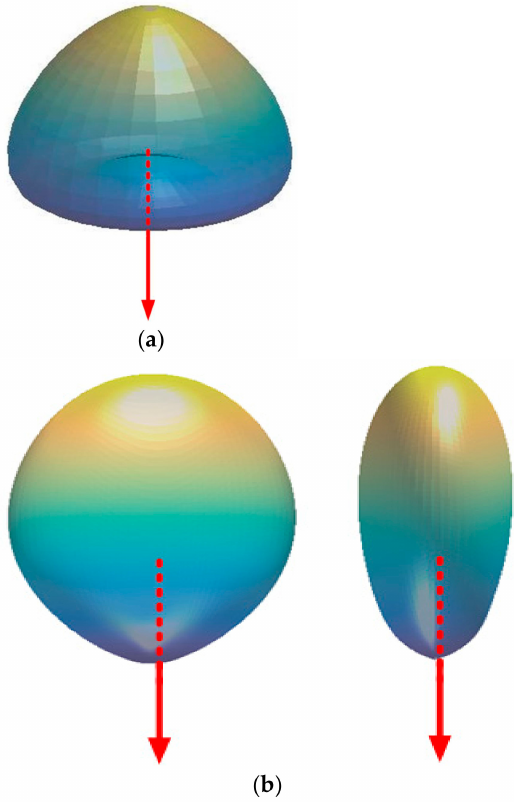
Figure 2. Three-dimensional spatial radiation characteristics of ( a ) LUXEON Rebel optical beam and ( b ) asymmetric NSPW optical beam from the wide side view and from the narrow side